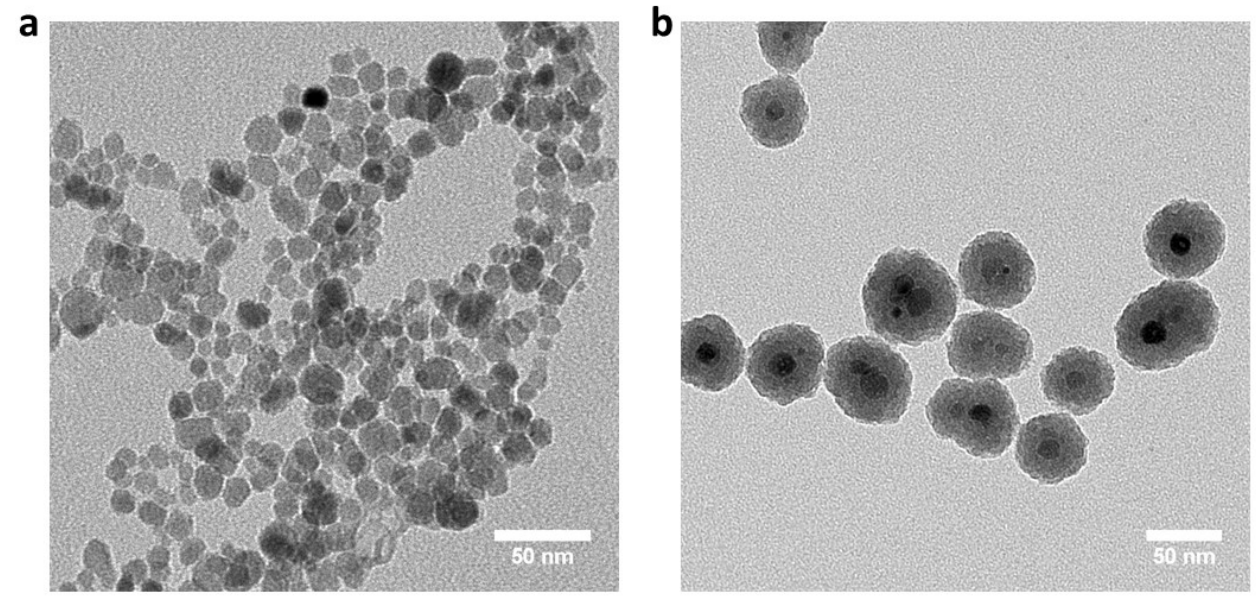
Figure 1. Representative transmission electron microscopy images of nanoparticles ( a ) EMG308 Fe nanoparticles and ( b ) silica-coated EMG308 nanoparticles.